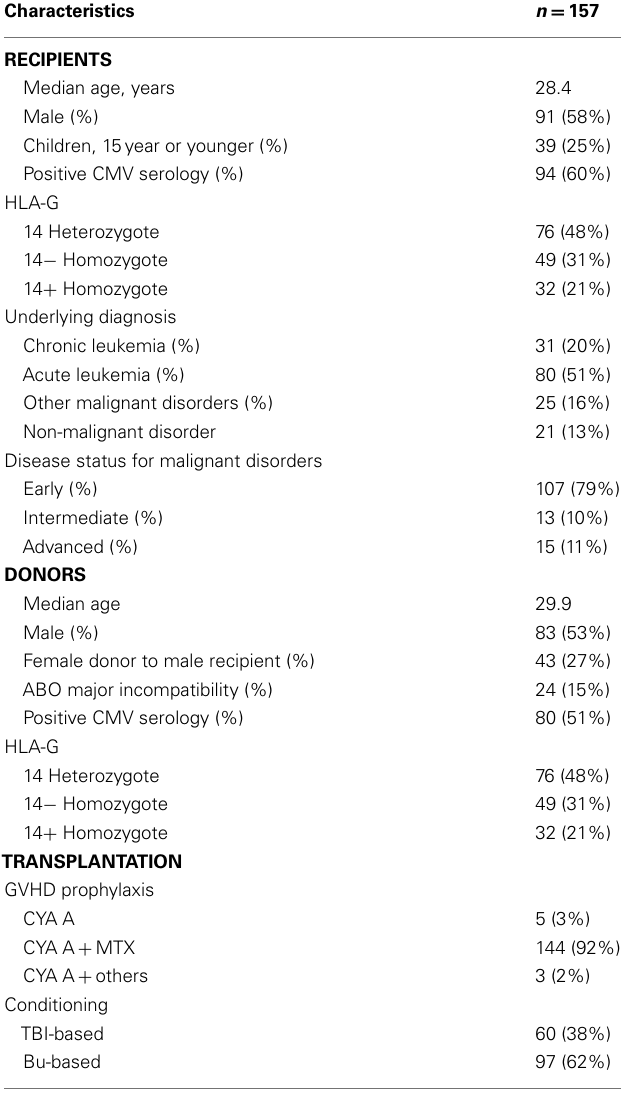
Table 1 | Patients, disease, and transplant